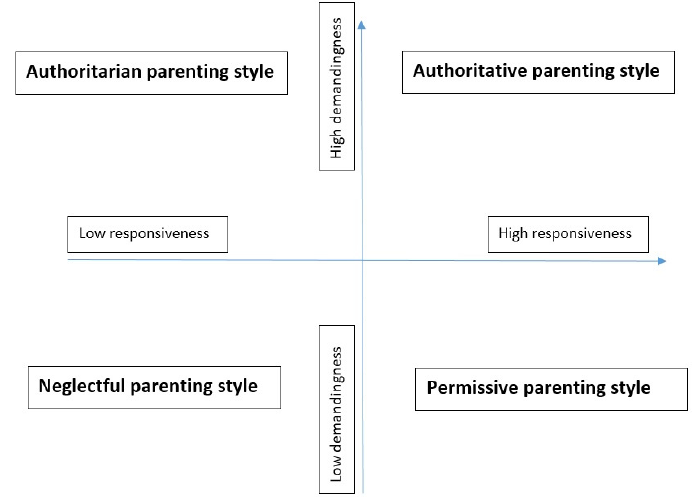
Figure 1. The Cartesian plane depicting parenting styles.